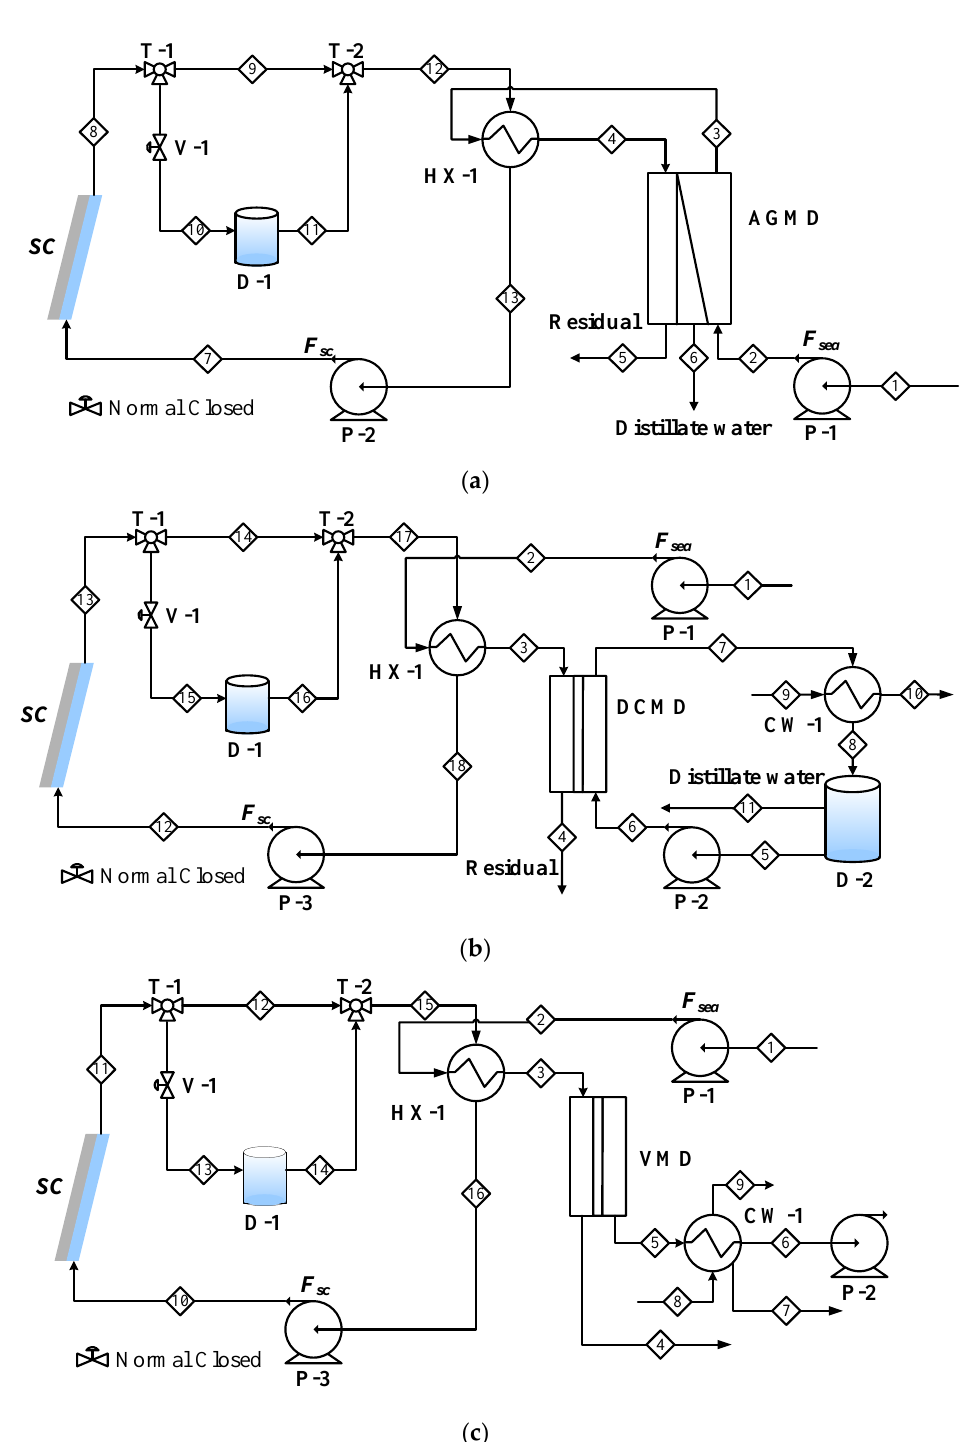
Figure 1. Process flow diagrams of solar-driven ( a ) AGMD, ( b ) DCMD, ( c ) VMD systems for desalination.